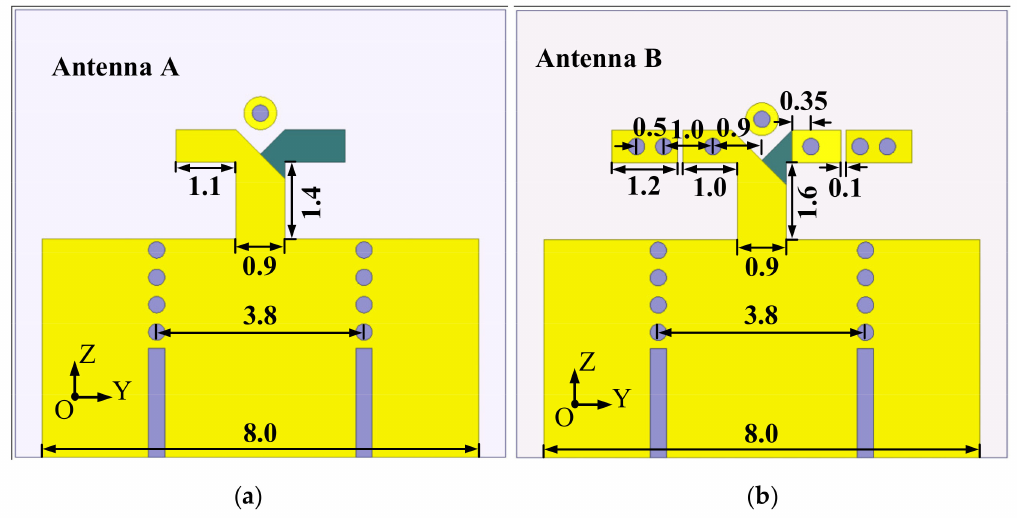
Figure 4. Two different SIW-fed printed dipole antennas: ( a ) routine half-wavelength dipole; ( b ) the proposed wideband folded